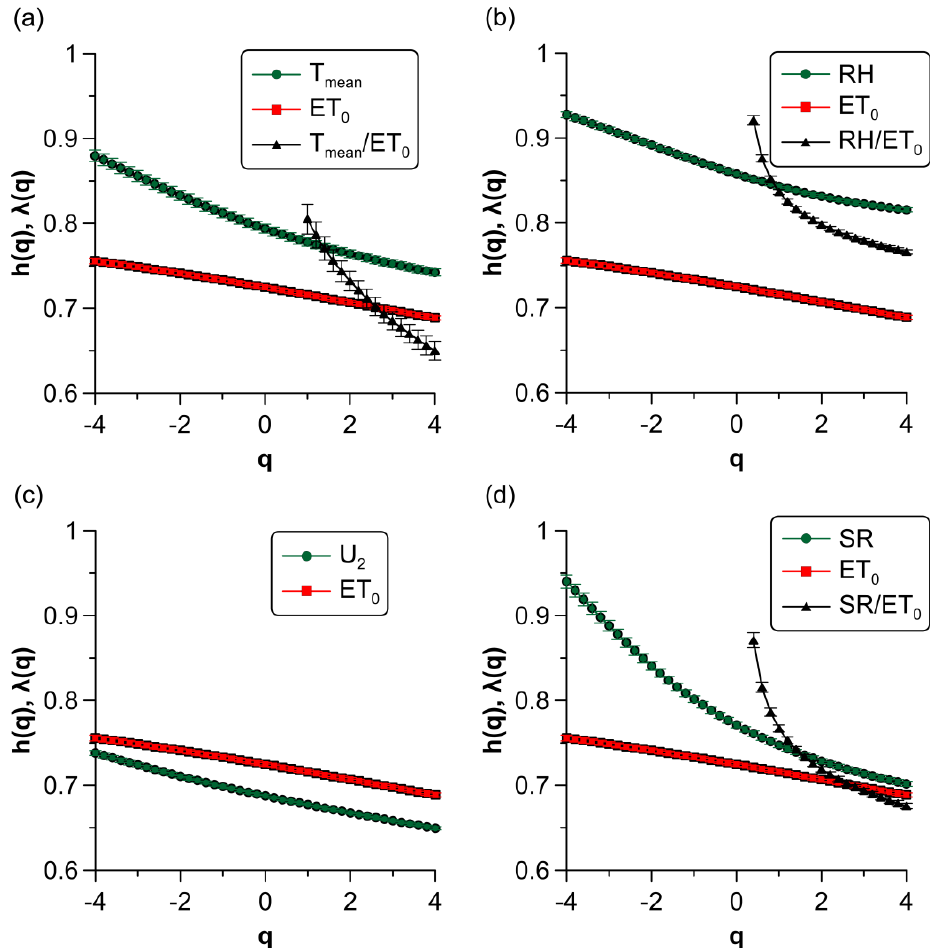
Figure 6. Multifractal cross-correlation exponents, 𝜆(𝑞), of meteorological variables with 𝐸𝑇 0 and their generalized Hurst exponents ℎ(𝑞) . ( a ) 𝑇 𝑚𝑒𝑎𝑛 — 𝐸𝑇 0 . ( b ) 𝑅𝐻—𝐸𝑇 0 . ( c ) 𝑈 2 —𝐸𝑇 0 . Multifractal cross-correlation was not observed in this case. ( d ) 𝑆𝑅— 𝐸𝑇 0 .